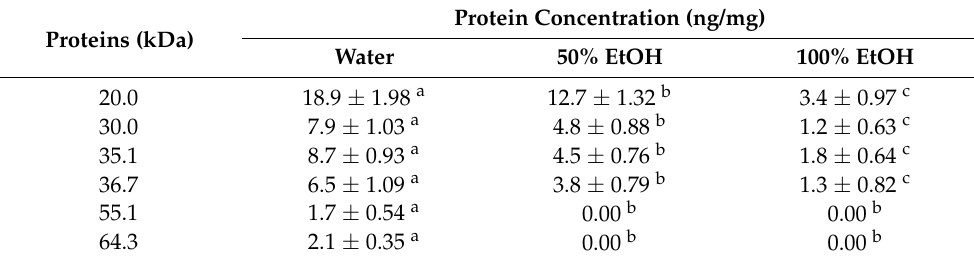
Table 1. Concentration of proteins in M. cochinchinensis seed extracts. Protein concentrations were calculated relative to the Odyssey One-Color molecular marker (Millennium Science, Sydney, Aus- tralia) and ImageLab software (Bio-Rad, Hercules, CA, USA). Results were presented as mean ± SEM ( n = 3), values in each row with different letters indicated statistical significance at p ≤ 0.05 (Analysis by One-way ANOVA with Turkey’s LSD